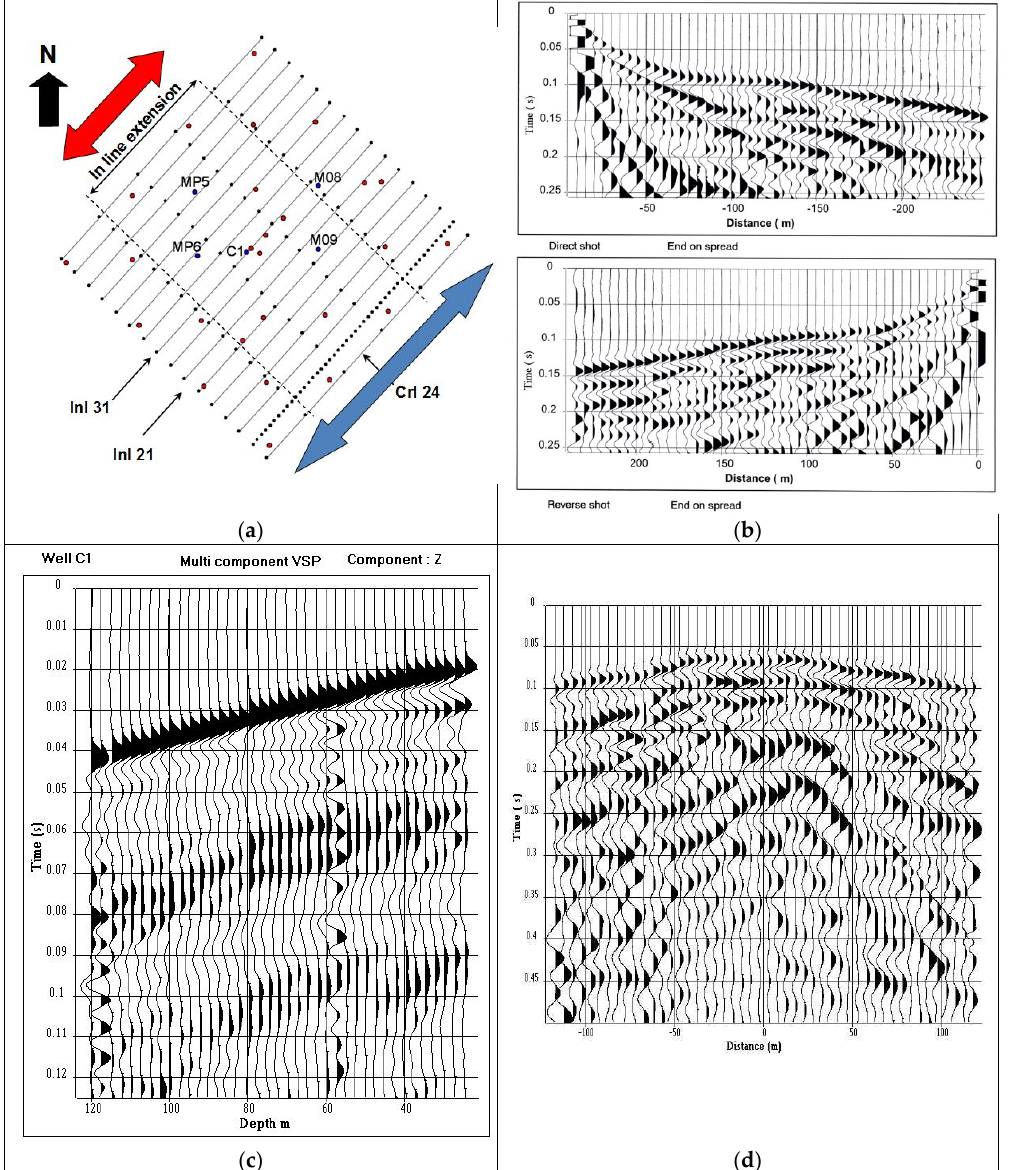
Figure 2. Three-dimensional seismic acquisition. ( a ) Seismic line implementation and well location (red points), ( b ) example of direct and reverse in-line shot points, ( c ) vertical seismic profile (VSP) at well C1, ( d ) example of crossline shot point.